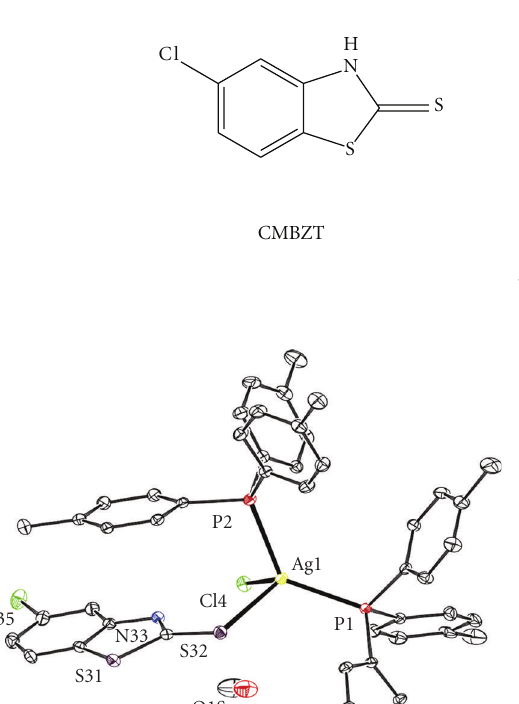
due to intramolecular contact S31 ··· O1S (i) = 3.240(6) ´˚A (Figure 1(b)) (the symmetry transformation used to gener- ate the equivalent atoms for (i) = − x , − y ,1 − z